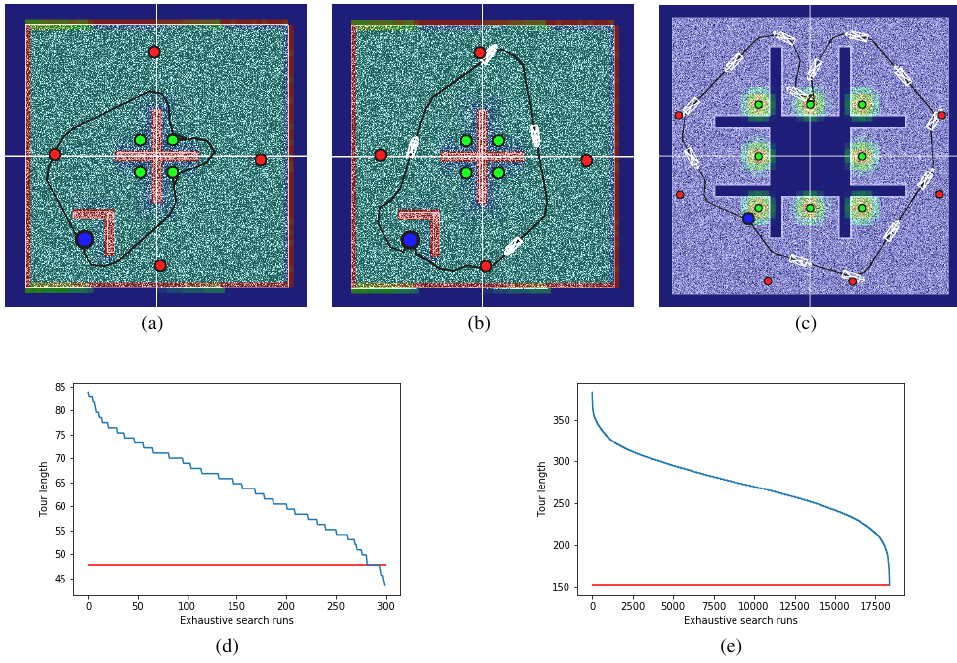
Figure 3. The optimal tour for the first dataset, determined by the exhaustive search (a) and the tour generated by our method (b). Both the optimal tour and the tour generated by our method for the second dataset (c). The start point is blue, points of interest are green and indirect viewpoints are red. The length of all tours examined by the exhaustive search for both datasets (e-f), the red lines show the tours determined by our method.